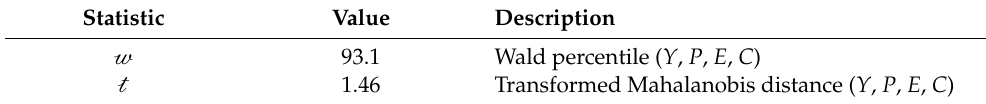
Table 3. Indirect inference test results.